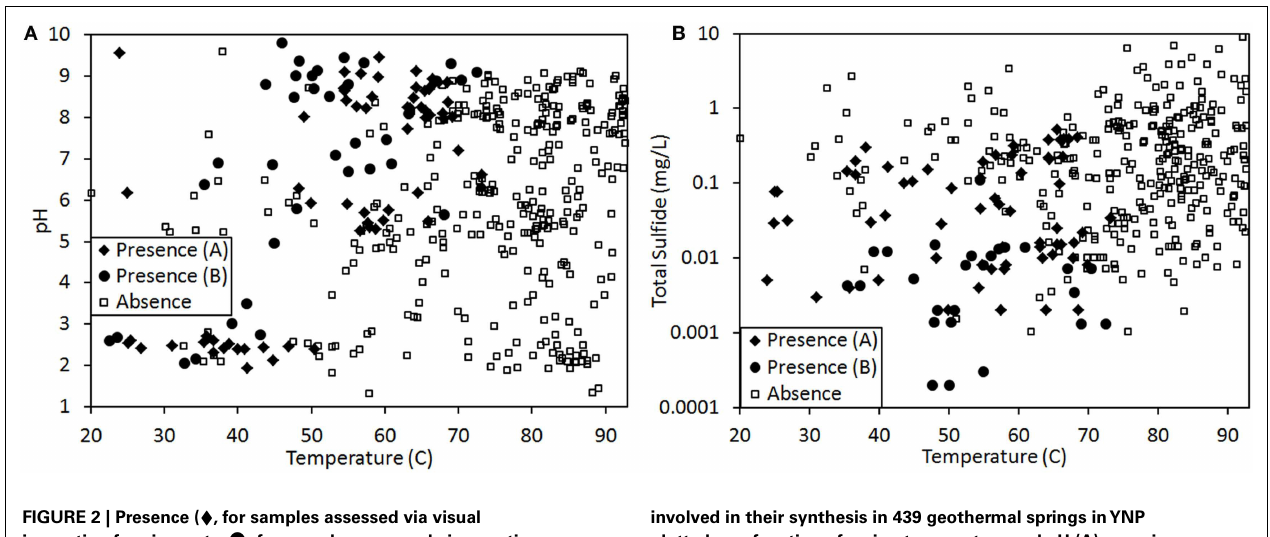
FIGURE 2 | Presence ( (cid:7) , for samples assessed via visual • inspection for pigments; , for samples assessed via genetic technique; see Materials and Methods for further description) and absence ( (cid:3) ) of phototrophic pigments and/or genes